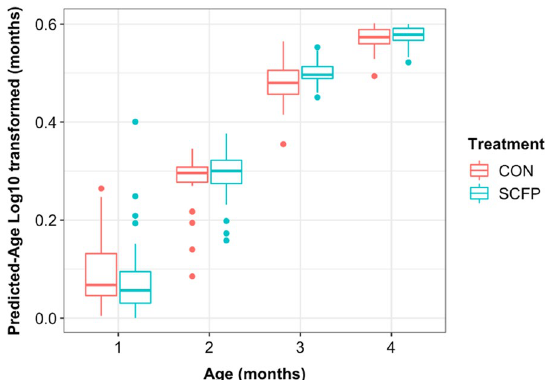
Fig. 4 Correlation of animal age with the predicted‑age log 10 transformed using the 40‑ASV RF model between CON and SCFP group across months of age. Numbers in the x‑axis represent the four months of age (1 28 d, 2 56 d, 3 84 d, and 4 112 d). Samples = = = = from the CON treatment represent the age‑discriminatory model training set and samples from the SCFP represent the model applied (testing